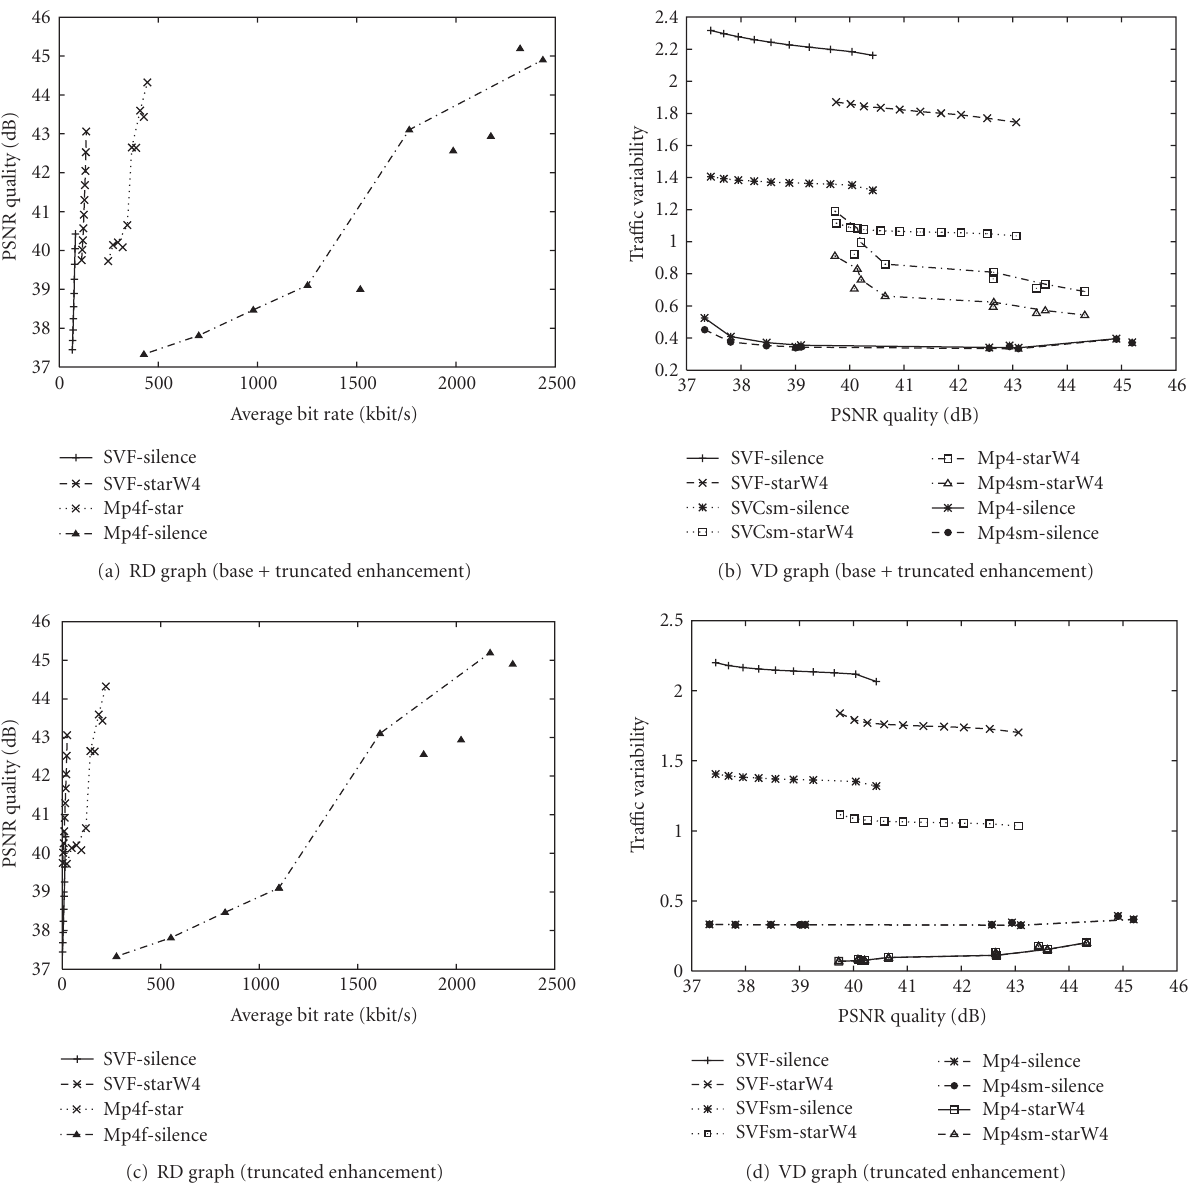
Figure 8: RD and VD curves of MPEG-4 FGS and SVC FGS enhancement layers truncated progressively with 10% increments, for Silence o/t Lambs and Star Wars IV